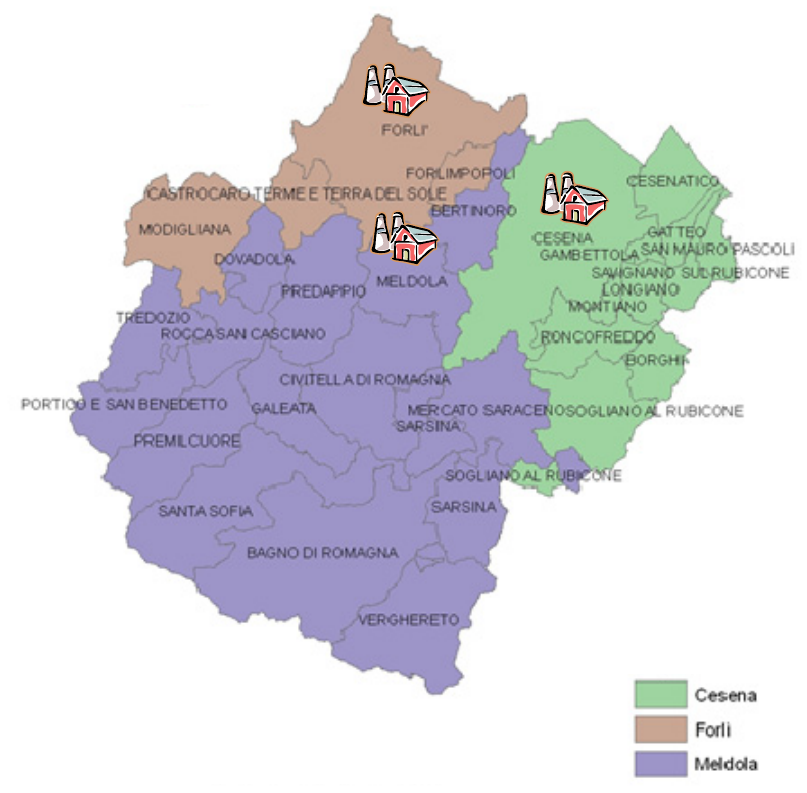
Figure 3. Supply basins of plants in the towns of Cesena, Forlì and